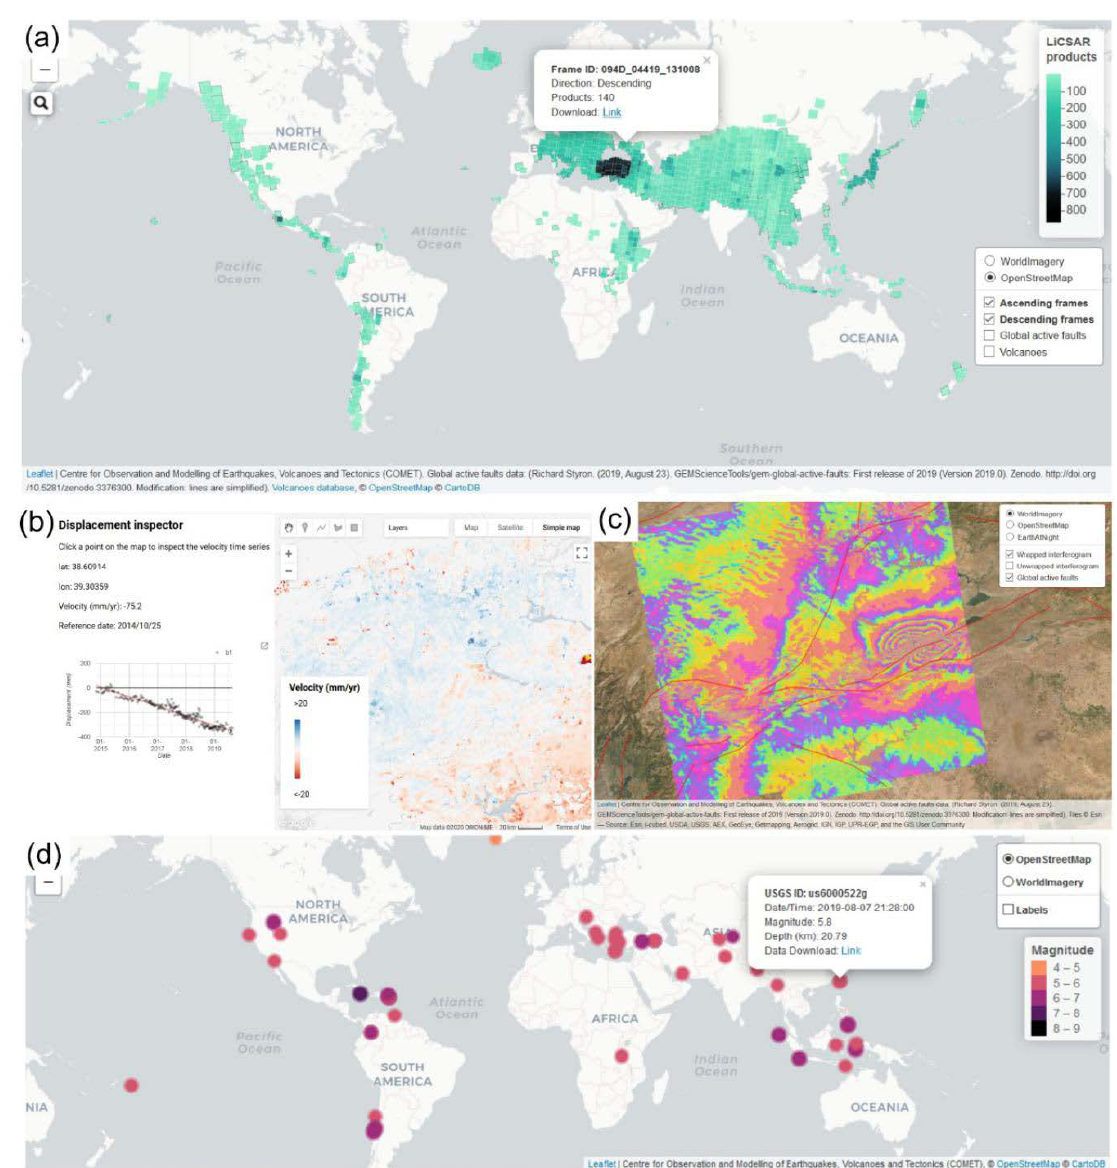
Figure 15. Components of the LiCSAR web portal. ( a ) LiCSAR frame coverage and data download links, ( b ) example of an interactive displacement time series for an area of Turkey (frame ID 116A_05167_121313) derived using LiCSBAS, ( c ) example of an interferogram (of frame ID 116A_05167_121313) processed following the Elazığ earthquake in Turkey (24th January 2020), and ( d ) Earthquake InSAR Data Provider map showing live LiCSAR responses.